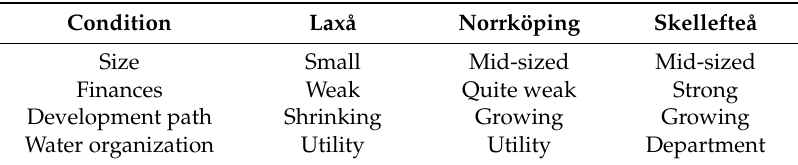
Table 2. Conditions in Laxå, Norrköping, and Skellefteå